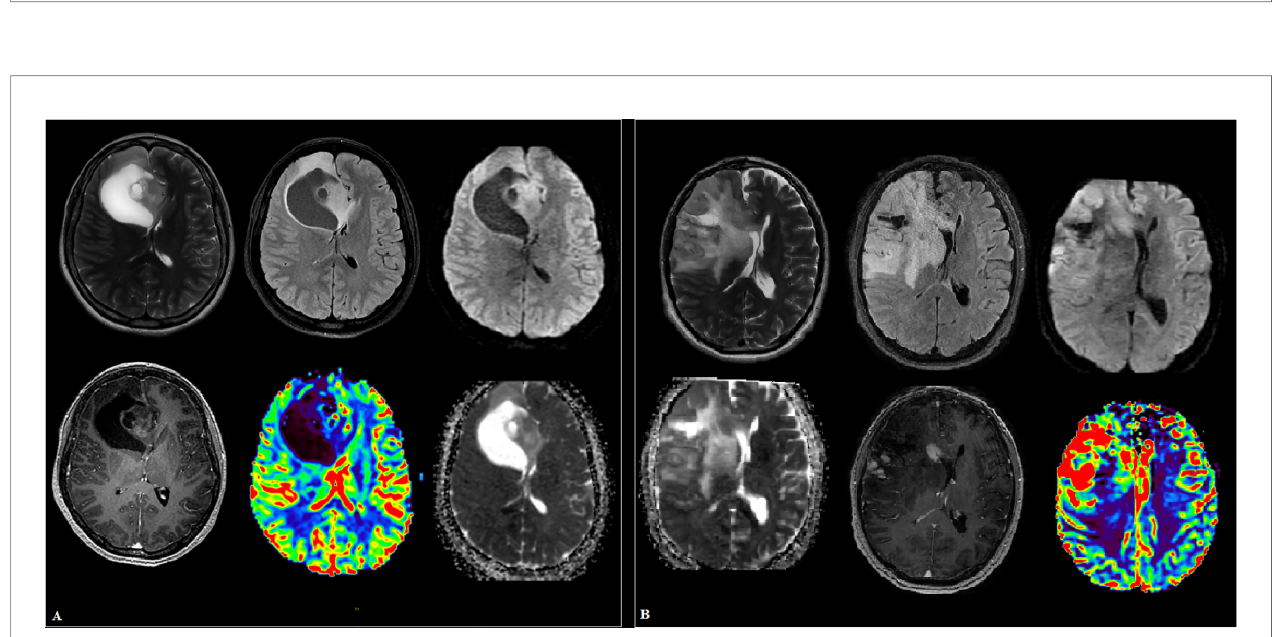
FIGURE 2 | Cases of high-grade glioma patients (A, B) . (A) Intracranial tumor of the right frontal lobe and genu corpus callosum, in addition to the white matter, involving the cortical plate with a mass effect on the anterior horn of the right lateral ventricle. The parasagittal solid component has small foci of hyperperfusion on dynamic susceptibility contrast (DSC) MR perfusion and areas of increased cellularity in apparent diffusion coef fi cient (ADC), is heterogeneous in signal in T2 weighted image (T2WI), and shows heterogeneous contrast enhancement. (B) A large “ intra-axial ” area of in homogeneously elevated signal in T2 and fl uid attenuation inversion recovery (FLAIR) in the right frontal lobe and basal ganglia, extending into the gray matter, the opposite hemisphere along the genu corpus callosum, with a group of subpial (and one subependial) nodules of homogeneous intense contrast enhancement. Against the background of uneven diffusion, zones of increased relative cerebral blood volume (rCBV) are revealed along the lateral contour of the right frontal